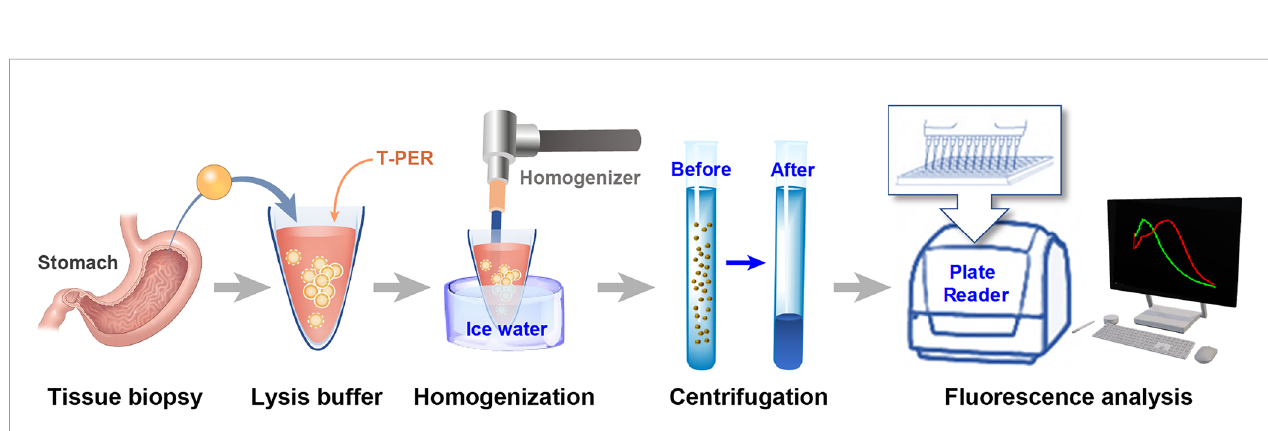
FIGURE 6 | The Process of enzyme activity analysis using tissue lysis